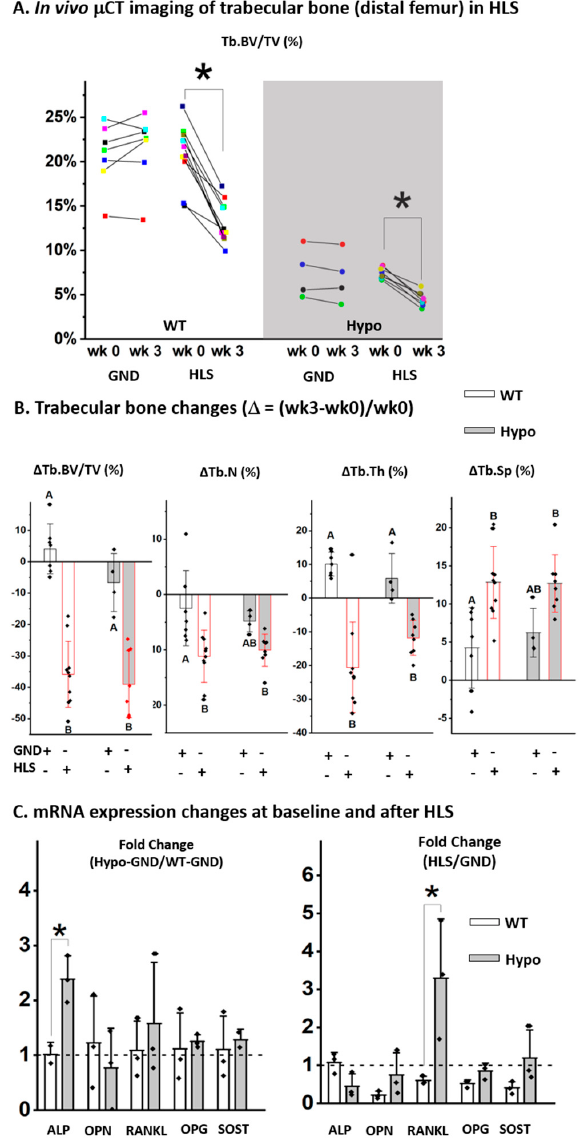
Figure 3. Trabecular bone responses to HLS were similar in WT and Hypo mice. ( A ) Sequential in vivo CT imaging showed bone loss after 3-weeks HLS regardless of genotype. ( B ) HLS-induced relative changes in the trabecular bone parameters were similar in Hypo and WT mice. ( C ) Fold-change of bone markers for GND control mice (Hypo-GND / WT-GND) and the fold-changes induced by HLS (HLS / GND) in both WT and Hypo mice (* p < 0.05, Student t test). Significance in multiple group comparisons was indicated by di ff erent letters (one-way ANOVA and Tukey post hoc